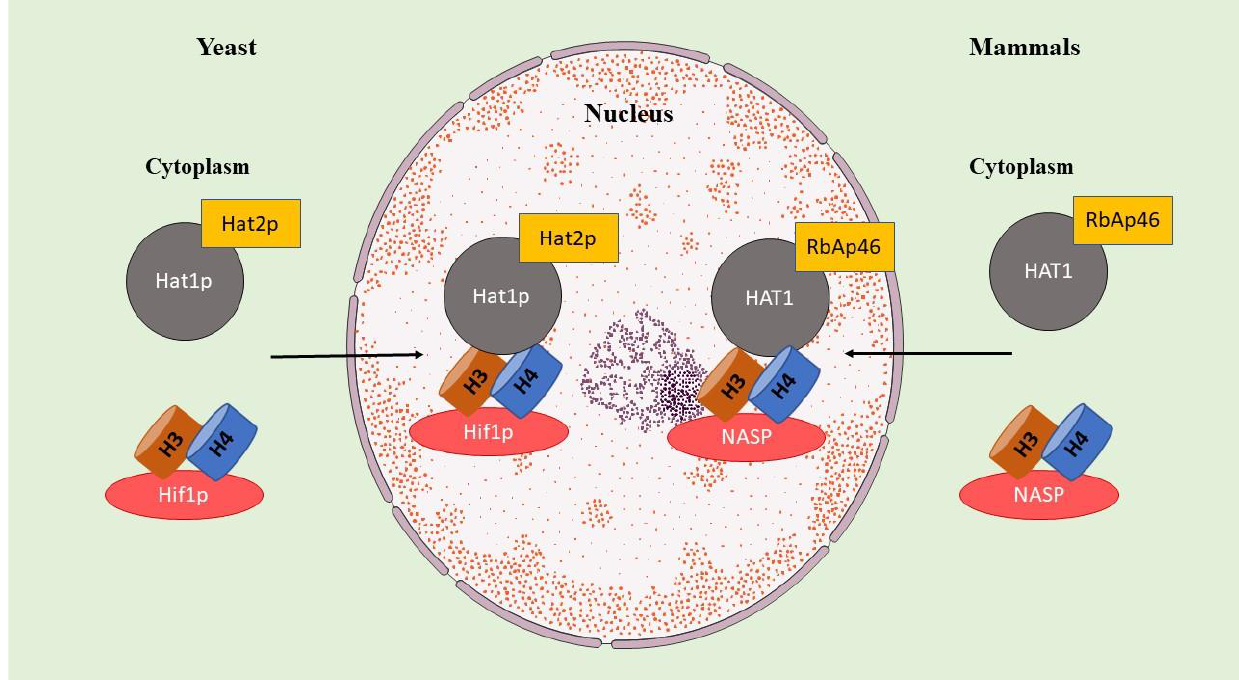
Figure 1. Scheme of complexes of HAT1 in nucleus (NuB4 complex) and cytoplasm compared in mammals and yeast. HAT1: histone acetyltransferase 1, NASP: nuclear autoantigenic sperm protein, RbAp46: Retinoblastoma protein-associated protein 46.